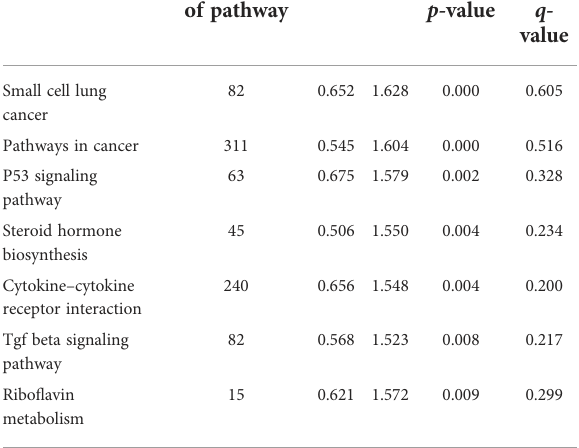
TABLE 2 KEGG enrichment analysis results